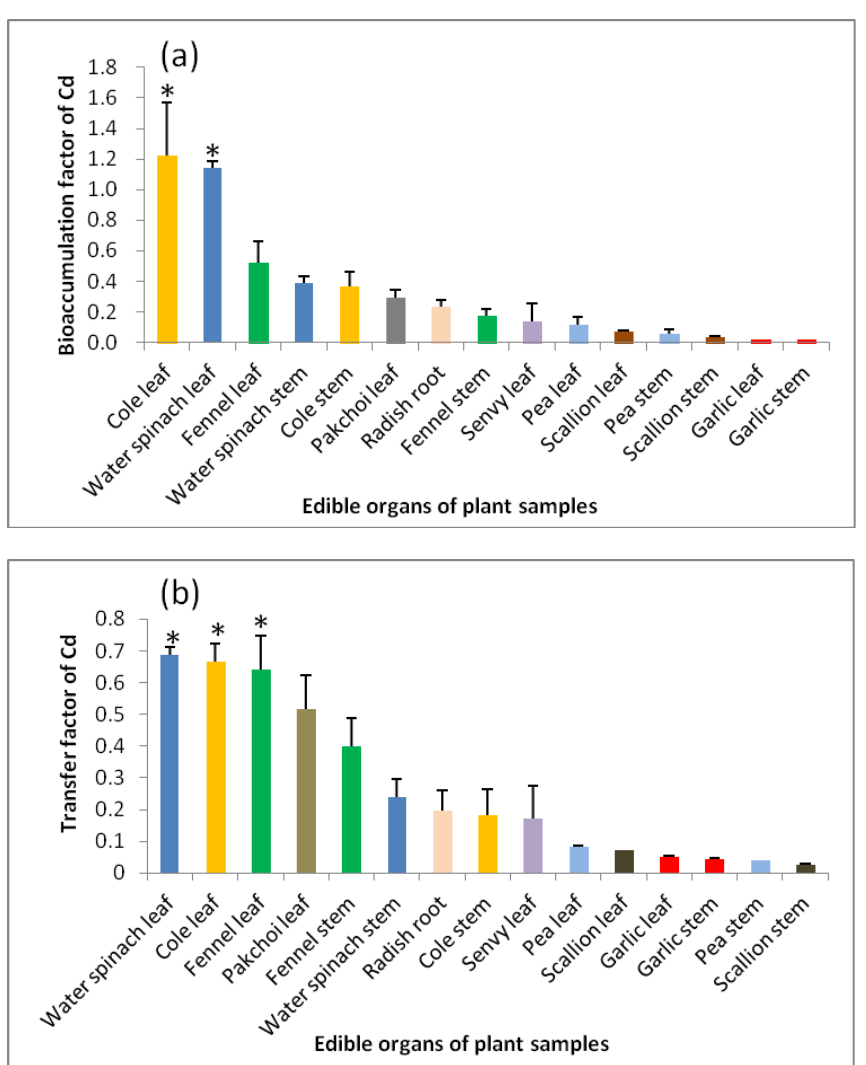
Figure 3. ( a ) Bioaccumulation factor (BF) and ( b ) transfer factor (TF) of Cd in edible parts of the vegetables (Mean ± SE, n = 4, DW). * indicates significant difference between different edible parts of nine vegetable at p < 0.05 level.